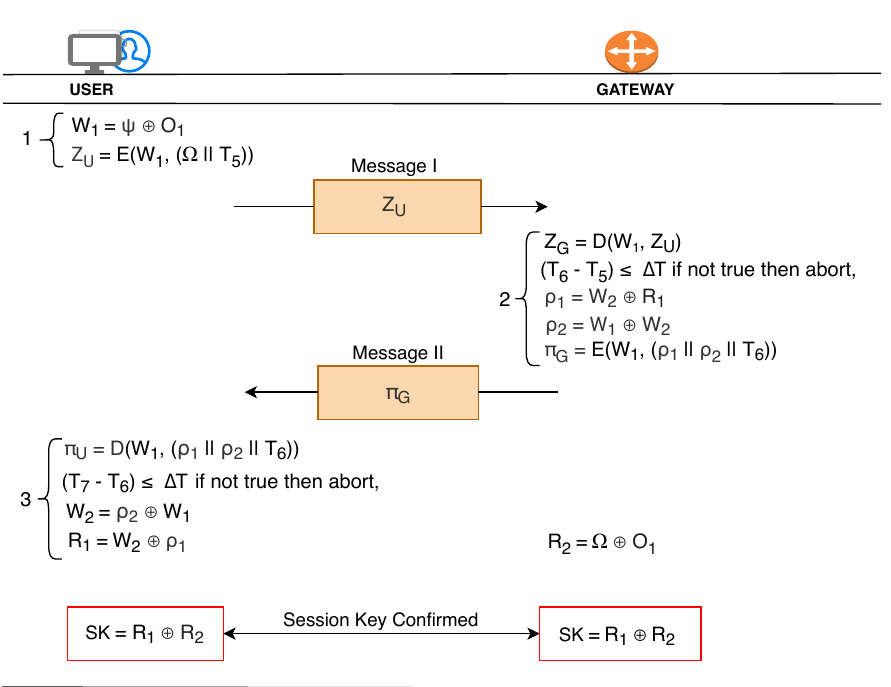
Figure 5. Mutual Authentication and Secret Key Generation Phase in MAKE-IT